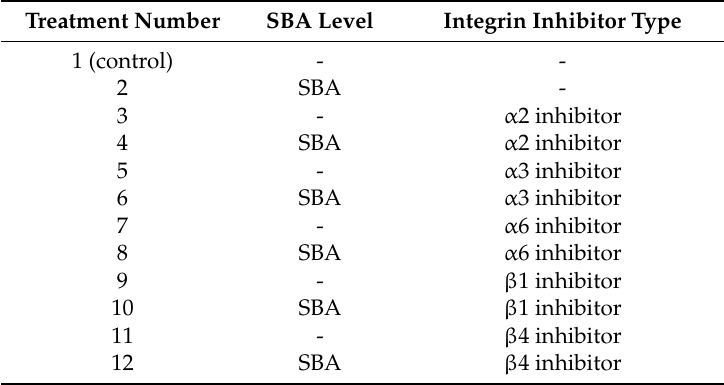
Table 3. Divided groups in integrin inhibitor